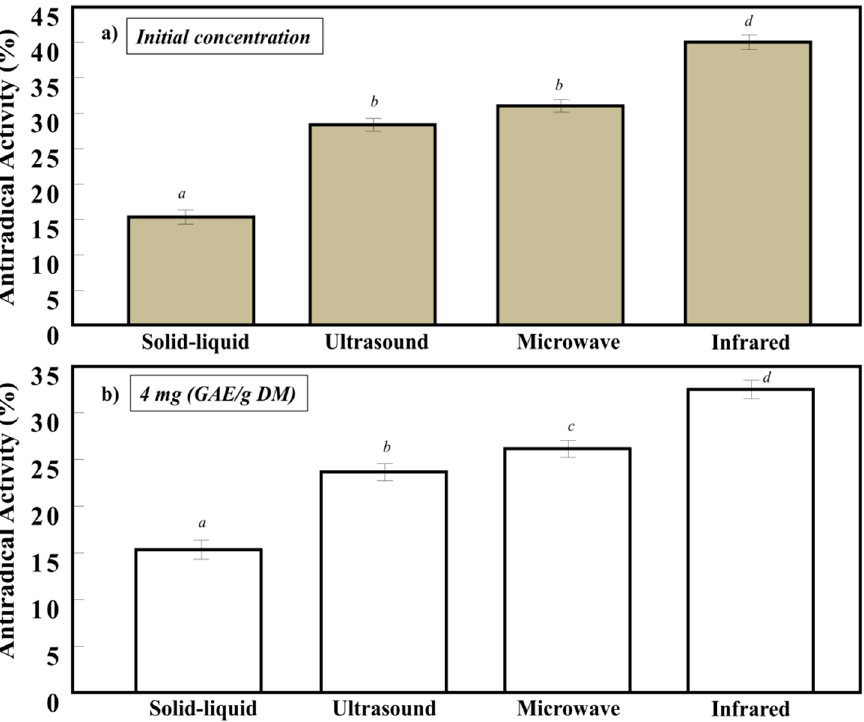
Figure 4. Antiradical scavenging capacity of apricot pomace treated with solid-liquid, ultrasound, microwave, and infrared extracts ( a ) at their initial concentration and ( b ) at 4 mg GAE/g DM of polyphenols. Different superscript letters indicate a significant statistical difference ( p < 0.05).